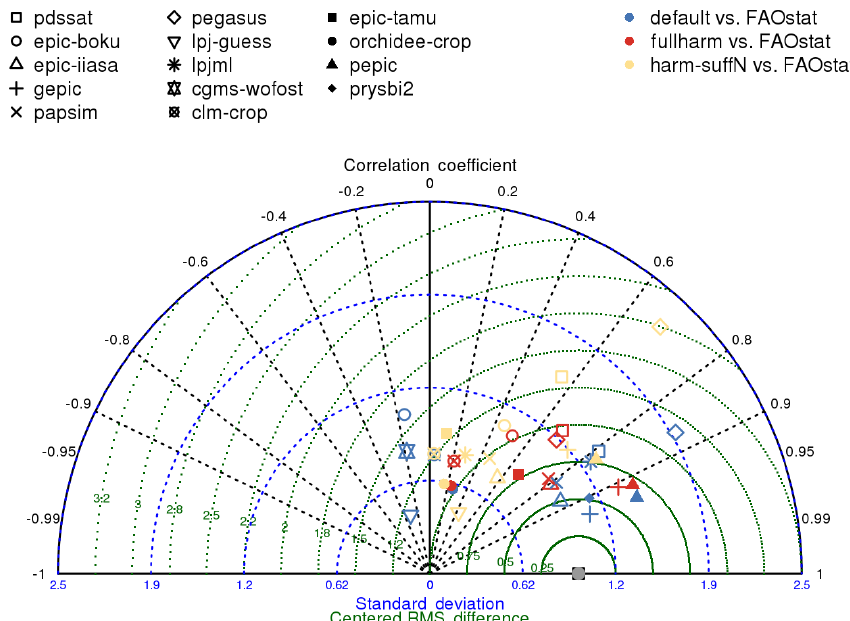
Figure 8. Taylor diagram of maize yield simulations aggregated to national level against FAO statistics data after removing trends but preserving national mean yields. A perfect match with FAO statistics data would be at the dark green box on the x axis, having a normalized standard deviation of 1 (distance to origin, blue contour lines) and a correlation of 1 (angle) as well as a centered RMSD of zero (green contour lines). Symbols represent the different GGCMs, colors indicate the harmonization setting. Non-significant correlations are shaded in lighter hues. Individual countries are weighted by their maize production according to FAOstat data